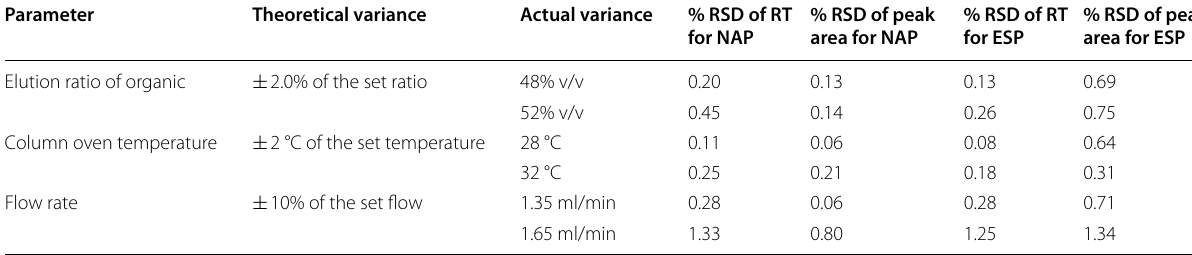
Table 9 Effects of robustness study of ESP and NAP under different altered conditions Parameter